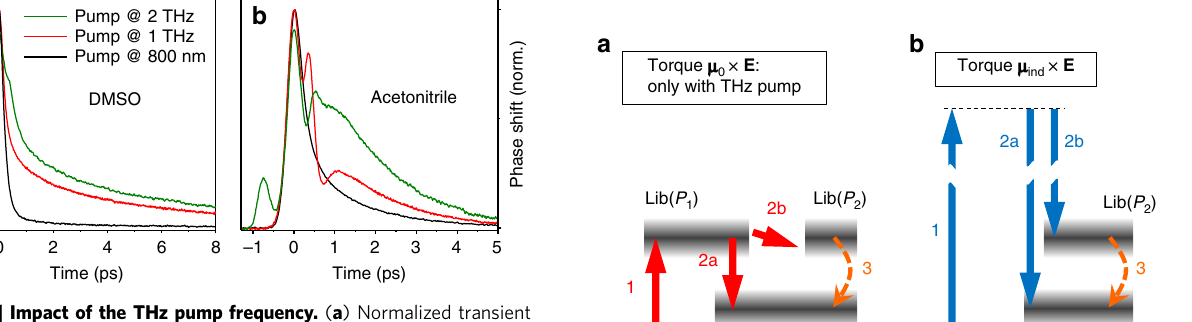
Figure 4 | Impact of the THz pump frequency. ( a ) Normalized transient birefringence signals of DMSO following excitation with THz pump pulses centred at B 1THz (red line) and B 2THz (green line). The THz pump spectra are shown in Fig. 1b (for THz temporal waveforms see Supplementary Fig. 7). For comparison, the signal induced by optical excitation is also shown (black line). ( b ) Same as a , but